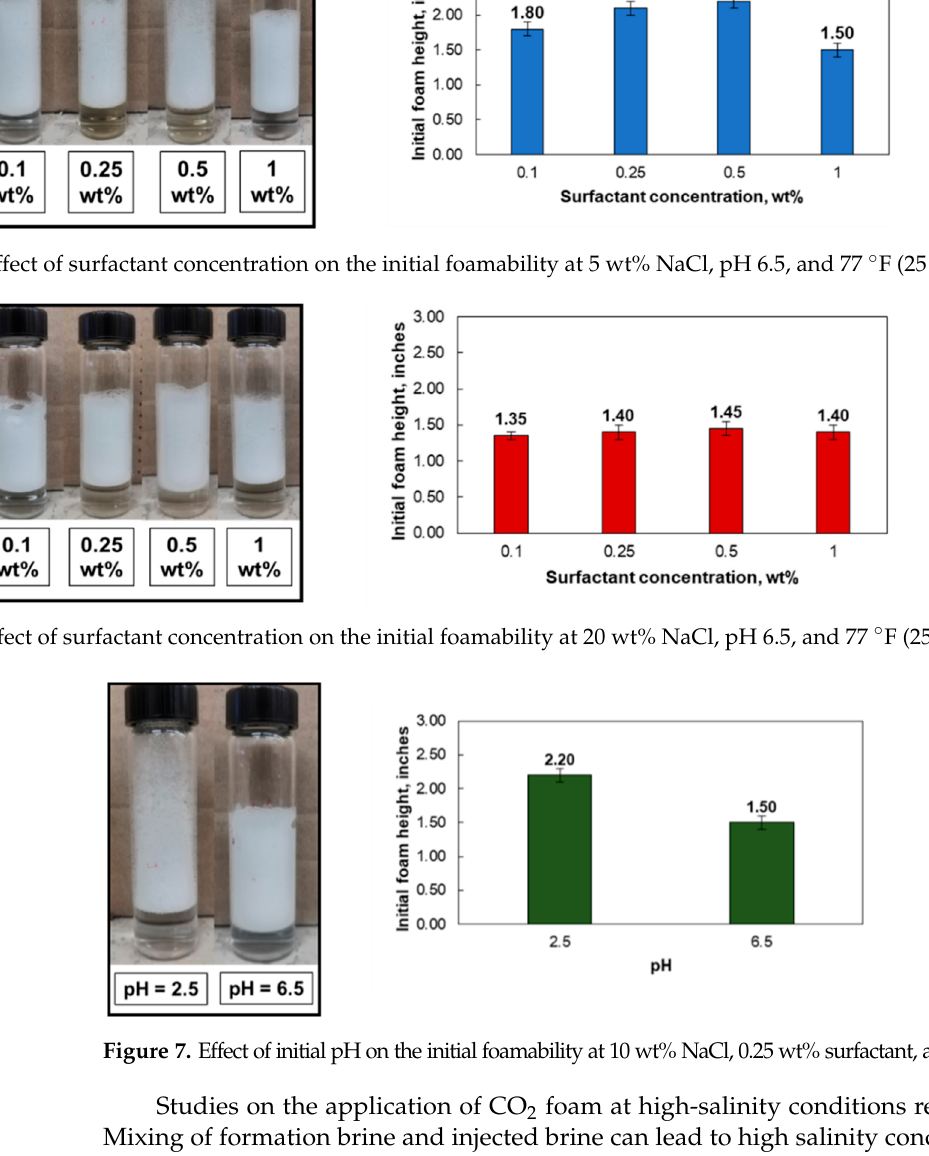
Figure 7. Effect of initial pH on the initial foamability at 10 wt% NaCl, 0.25 wt% surfactant, and 77 °F (25 °C).